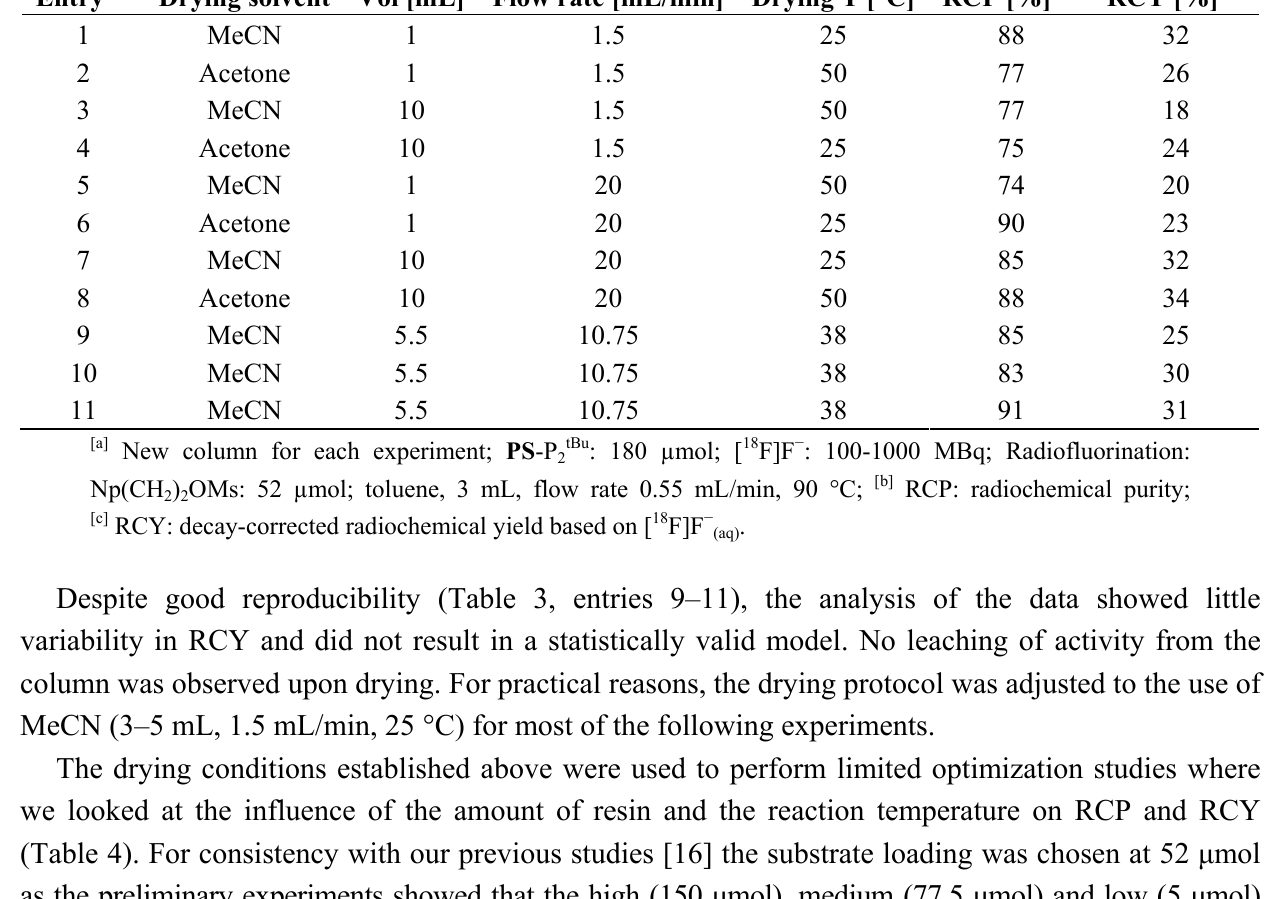
Table 3. Effect of column drying on radiofluorination of Np(CH